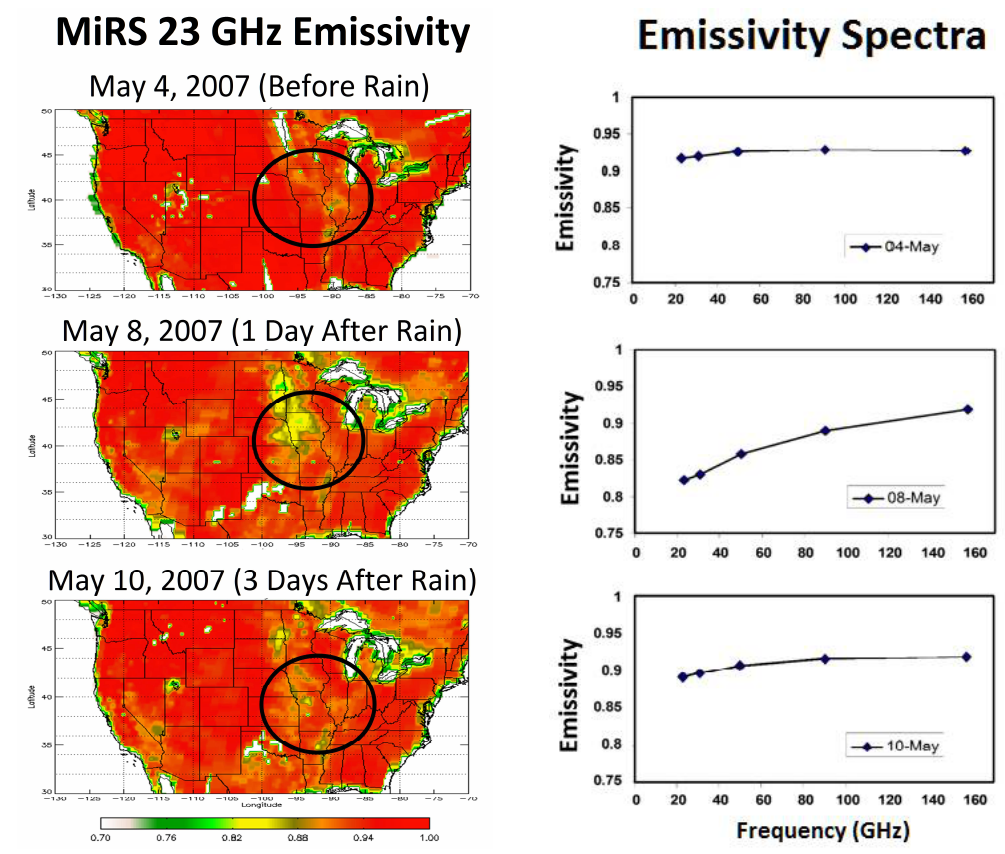
Figure 6. MiRS-based emissivity maps and spectra, before ( top ), shortly after ( middle ) and three days after ( bottom ) the rain events in Midwestern US, shown in previous figure. Circles highlight the areas where the spectra were computed from, corresponding to rain events. The emissivity absolute values and spectra behave as expected, going from their dry land emissivity values and almost flat spectrum before the rain, to much lower values (and water-like spectrum) right after the rain. After a few days of drying, the emissivities go back (although not fully) to their higher values and dry-like flat spectrum.